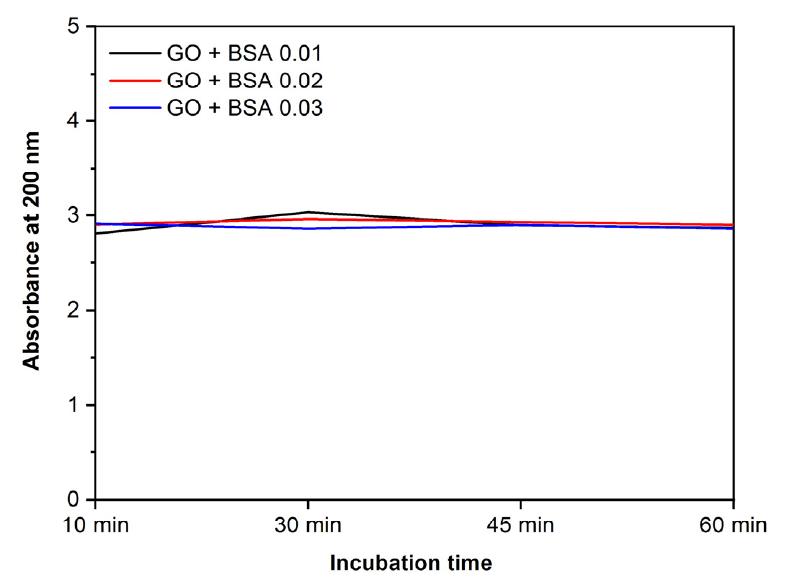
Figure 5. Absorbance at 200 nm vs. incubation time. GO (0.25 mg/mL) with different concentrations of BSA.